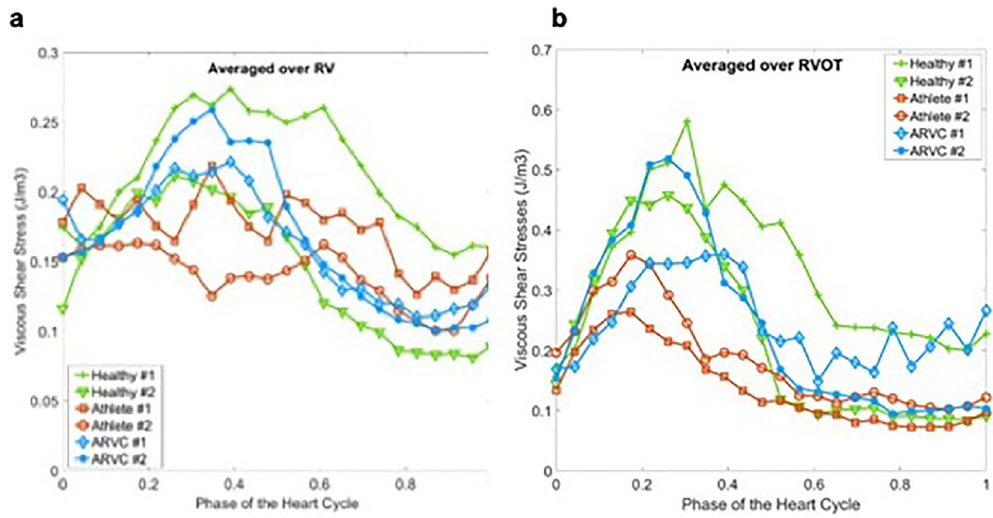
Figure 4. ( a ) Time evolution of viscous shear stress (VSS) averaged over RV for healthy probands, athletes and patients with ARVC. ( b ) Time evolution of viscous shear stress (VSS) averaged over RVOT for healthy probands, athletes and patients with